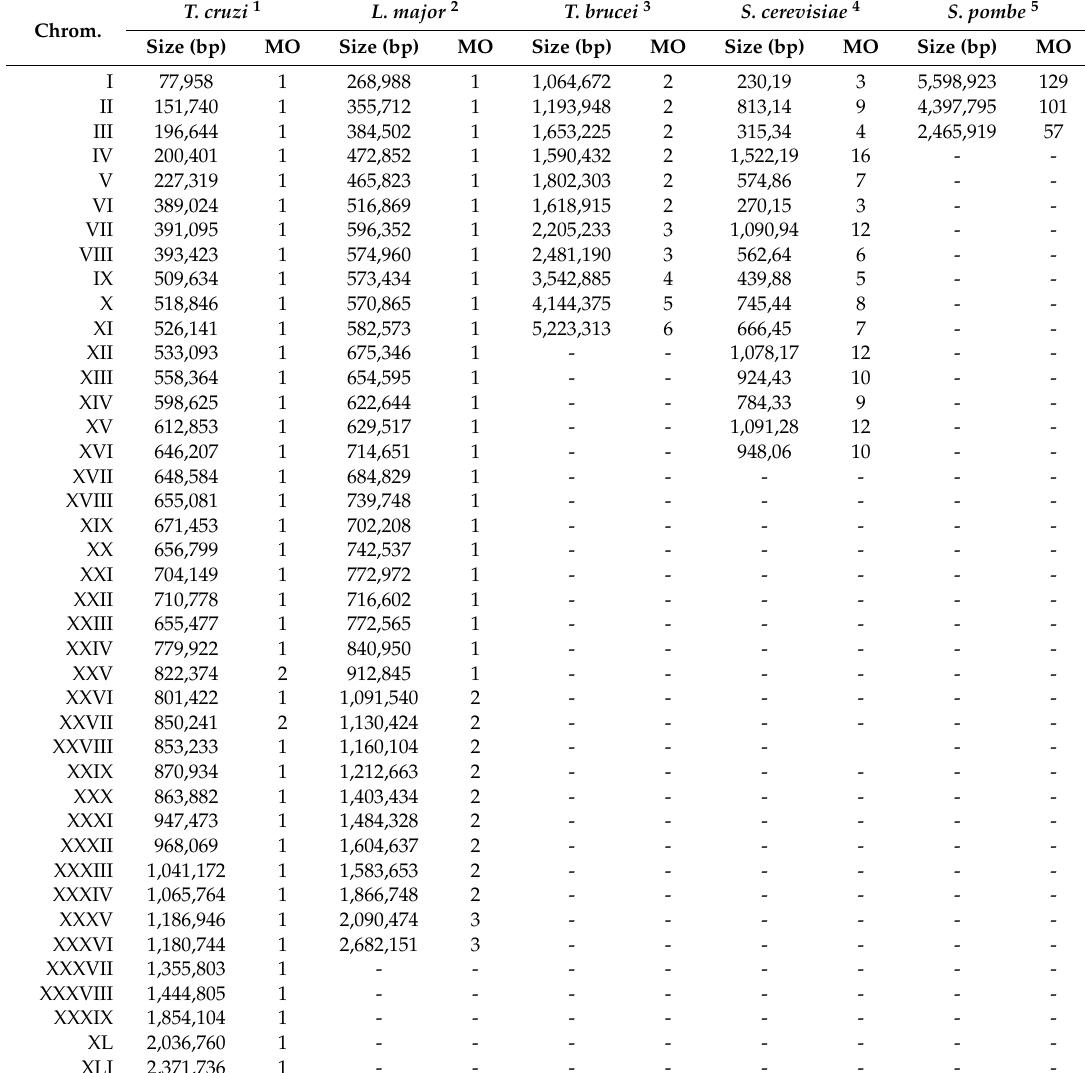
Table 1. Calculation of the minimum number of origins (MO) per chromosome in trypanosomatids ( T. cruzi , L. major , and T. brucei ) and yeasts ( S. cerevisiae and S. pombe ).